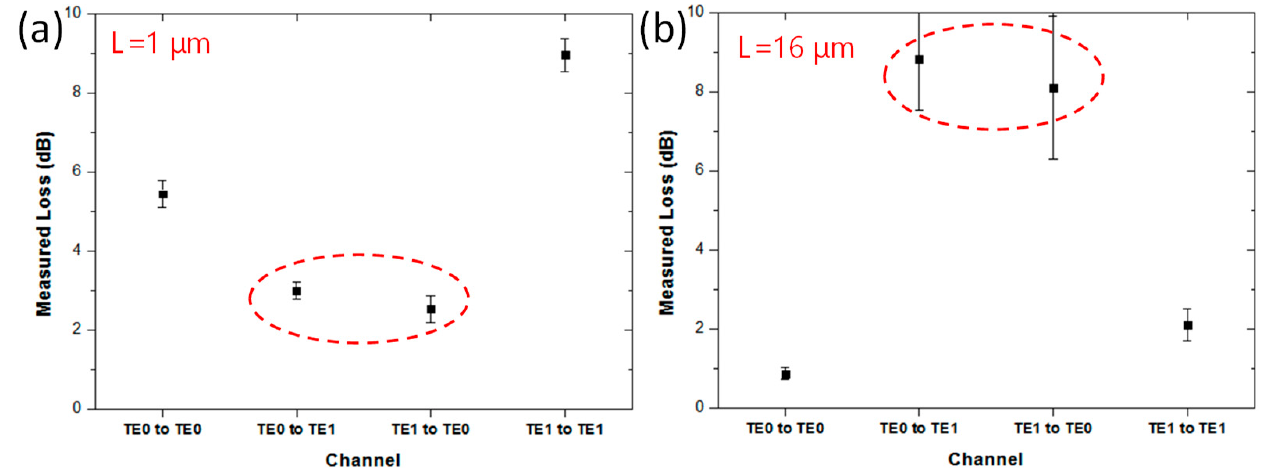
Figure 4. Experimental results of length dependency of a straight multimode bus waveguide be- tween two Euler bends with straight waveguide lengths ( a ) L = 1 µ m (period pattern trough), and ( b ) L = 16 µ m (period pattern peak).